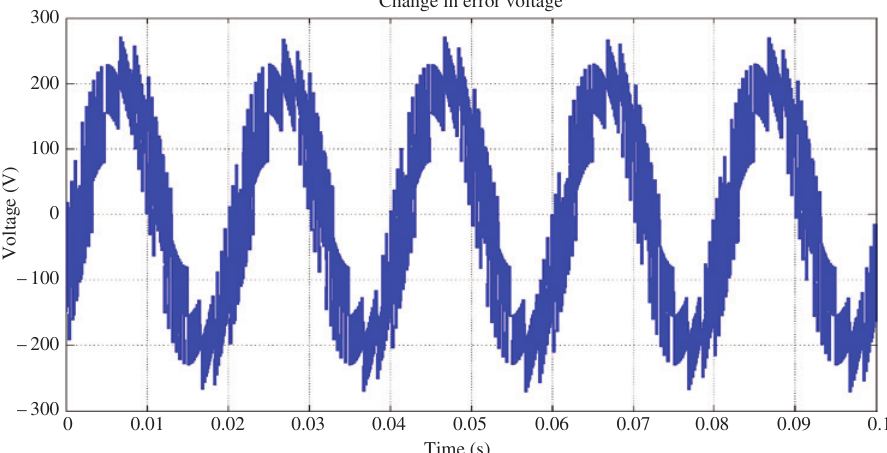
Figure 8: Change in Error Voltage Graph.